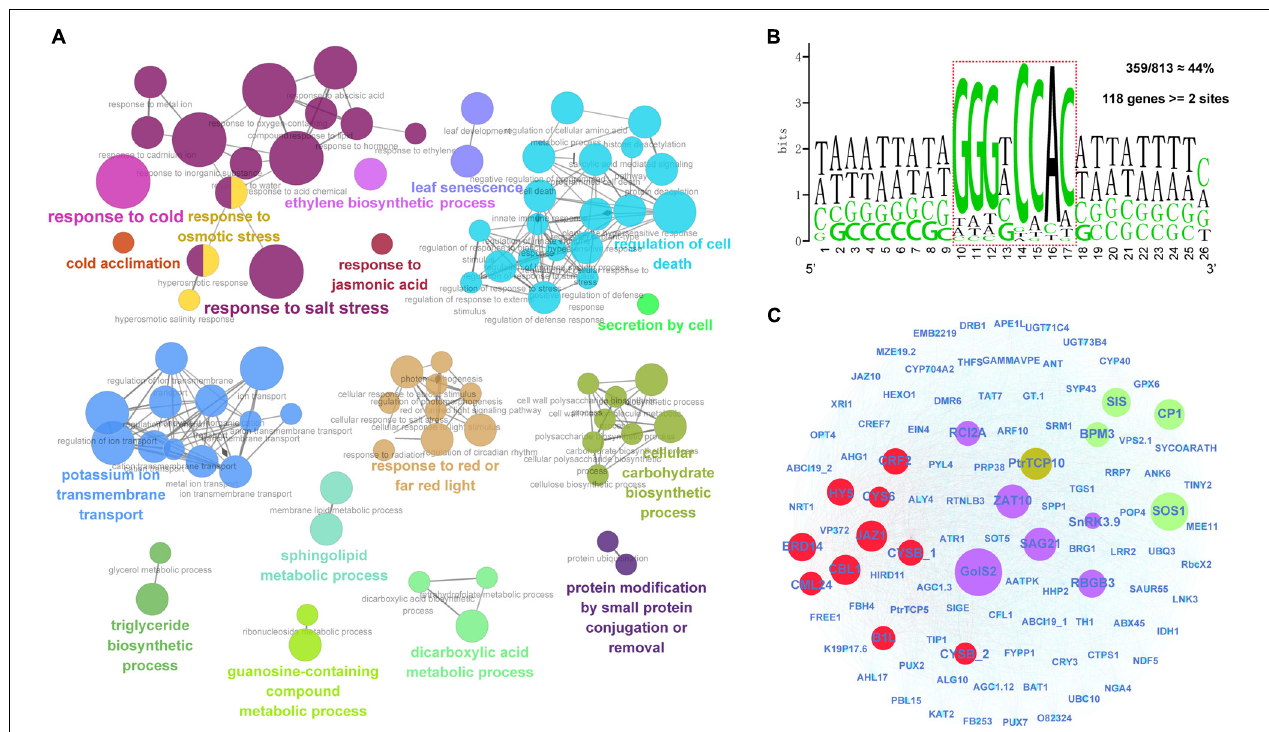
FIGURE 10 | PtrTCP10-mediated regulatory network under cold and salt stresses. (A) Functionally grouped networks on the enriched GO terms from the co-expressed genes of PtrTCP10 under cold and salt stresses. The enriched terms were linked according to their K score ( ≥ 0.3). (B) An enrichment of PtrTCP10 binding cis-regulatory elements in promoters (1-kb) of the 813 co-expressed genes. The sequence in dotted box indicates the core region potentially bind by PtrTCP10 . Approximately, 44% (359 out of 813) of the PtrTCP10 co-expressed genes’ promoters contained this cis -regulatory element, and 118 PtrTCP10 co-expressed genes contained at least two elements. (C) PtrTCP10-mediated regulatory network based on the high-confidence target genes of PtrTCP10. The red and green circles represent the well-known cold and salt responsive gene, and the purple circles represent the genes that could respond to both the cold and salt